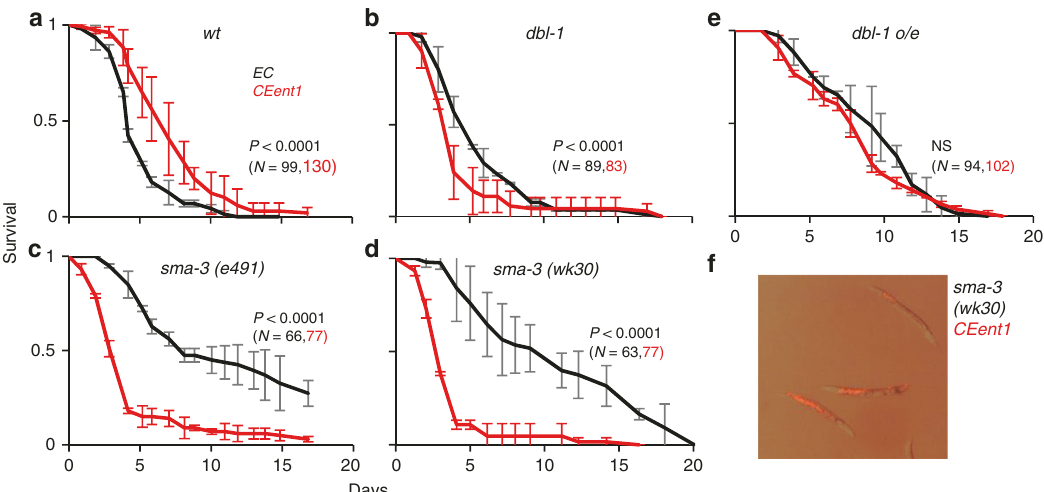
Fig. 6 Normally bene fi cial Enterobacter commensal is detrimental in dbl-1 mutants. a – e Fraction survival of worms of the designated strains on the pathogen E. faecalis , following growth (until larval stage L4) on control E. coli (EC) or CEent1 . Shown are averages ± SDs for representative experiments performed in duplicate or triplicate. P -values were obtained using log-rank test. f An overlay of visible light and fl uorescent images demonstrating colonization of sma-3 mutants with tdTomato-expressing CEent1 24 h after shift from CEent1 to E. faecalis (a representative image from one experiment of two showing similar results) ; size bar, 0.2